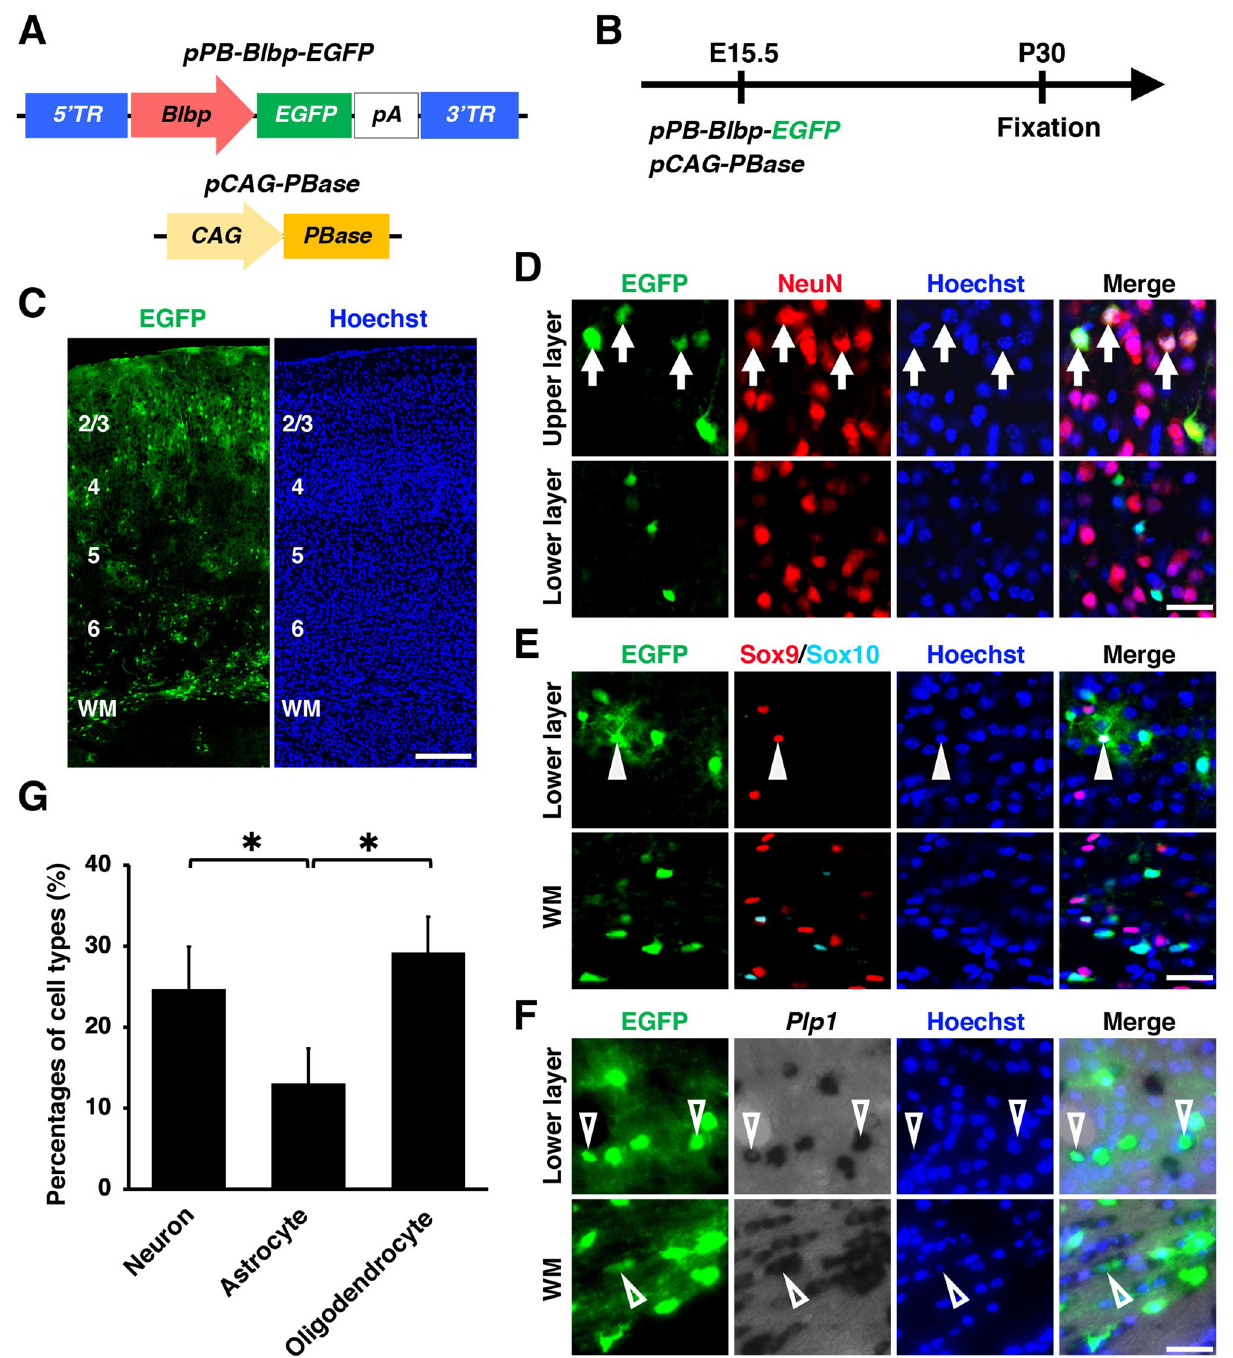
Figure 3. A Blbp promoter did not induce astrocyte-specific transgene expression when used with the piggyBac system and in utero electroporation. ( A ) Schematics of pPB-Blbp-EGFP and pCAG-PBase plasmids. pPB-Blbp- EGFP drives EGFP expression under a Blbp promoter. ( B ) Experimental procedure. pPB-Blbp-EGFP and pCAG- PBase were co-electroporated into the mouse cerebrum at E15.5, and coronal sections were prepared at P30. ( C ) Coronal sections of the electroporated cerebrum. Many EGFP-positive cells were distributed throughout the gray matter and the white matter. ( D – G ) Immunohistochemistry for NeuN (D), Sox9 and Sox10 ( E ), and in situ hybridization for Plp1 ( F ). Although EGFP-positive cells contained Sox9-positive/Sox10-negative astrocytes (arrowheads), they also contained NeuN-positive neurons (arrows) and Plp1 -positive oligodendrocytes (open arrowheads). ( G ) The percentages of EGFP-positive cells which were also NeuN-positive (neuron), Sox9-positive/ Sox10-negative (astrocyte) or Plp1 -positive (oligodendrocyte). This Blbp promoter drove gene expression not only in astrocytes but also in neurons and oligodendrocytes. Unpaired Student’s t -test, * P < 0.05. Error bars represent mean ± SD. The statistical analyses were performed using Microsoft Excel ver. 16.43. Scale bars: 200 μm ( C ), 30 μm ( D – F ). TR, terminal region; WM, white matter. Numbers indicate layers in the cerebral